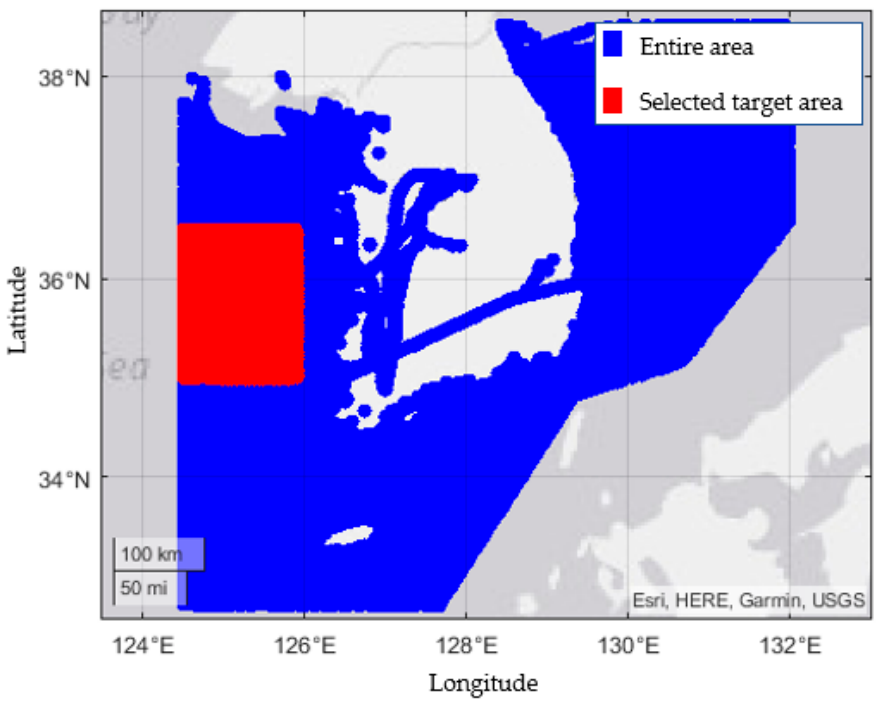
Figure 2. Selected target sea area.